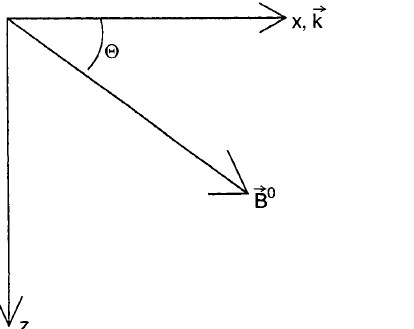
Fig. 1. The coordinate system for the Hall-MHD mode